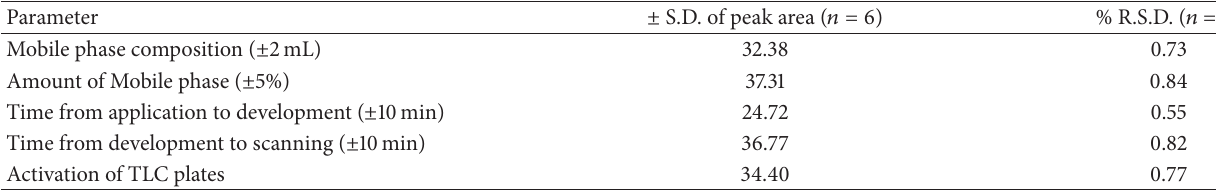
Table 3: Robustness of the method.